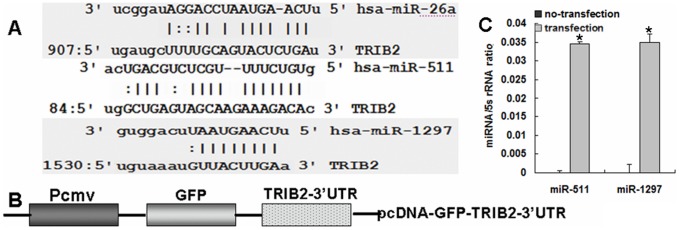
The targeting sites of TRIB2–3′UTR and structural map of the vector.(A) The targeting sites on TRIB2–3′UTR. miR-511, miR-1297 and miR-26a are shown. Each miRNA is aligned with the mRNA of human TRIB2 with the nucleotide position on the TRIB2 mRNA indicated. Vertical lines indicate identity; gaps indicate mismatch. (B) Structural map of the pcDNA-GFP-TRIB2–3′UTR vector. 3′-UTR of TRIB2 is indicated downstream of the GFP gene. Pcmv: cmv promoter. GFP: green fluorescent protein. TRIB2–3′UTR, 3′-UTR of the TRIB2 gene. (C) Real-time PCR detection. 24 h after lung adenocarcinoma cells were treated with miRNAs, higher miR-511 and miR-1297 levels were found in the transfected cells than in the non-transfected cells.